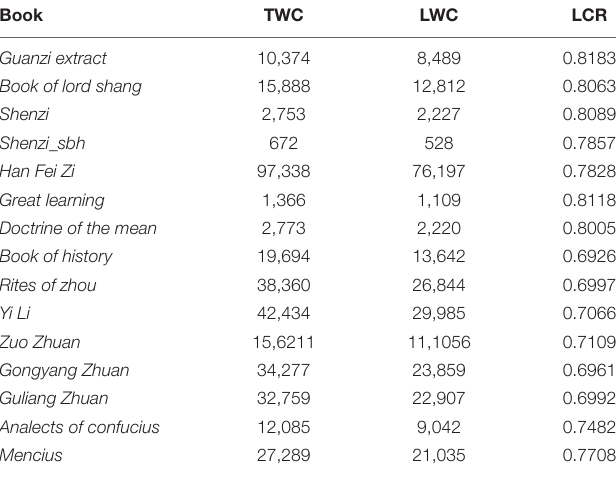
TABLE 2 | Word counts of Confucian and Legalist